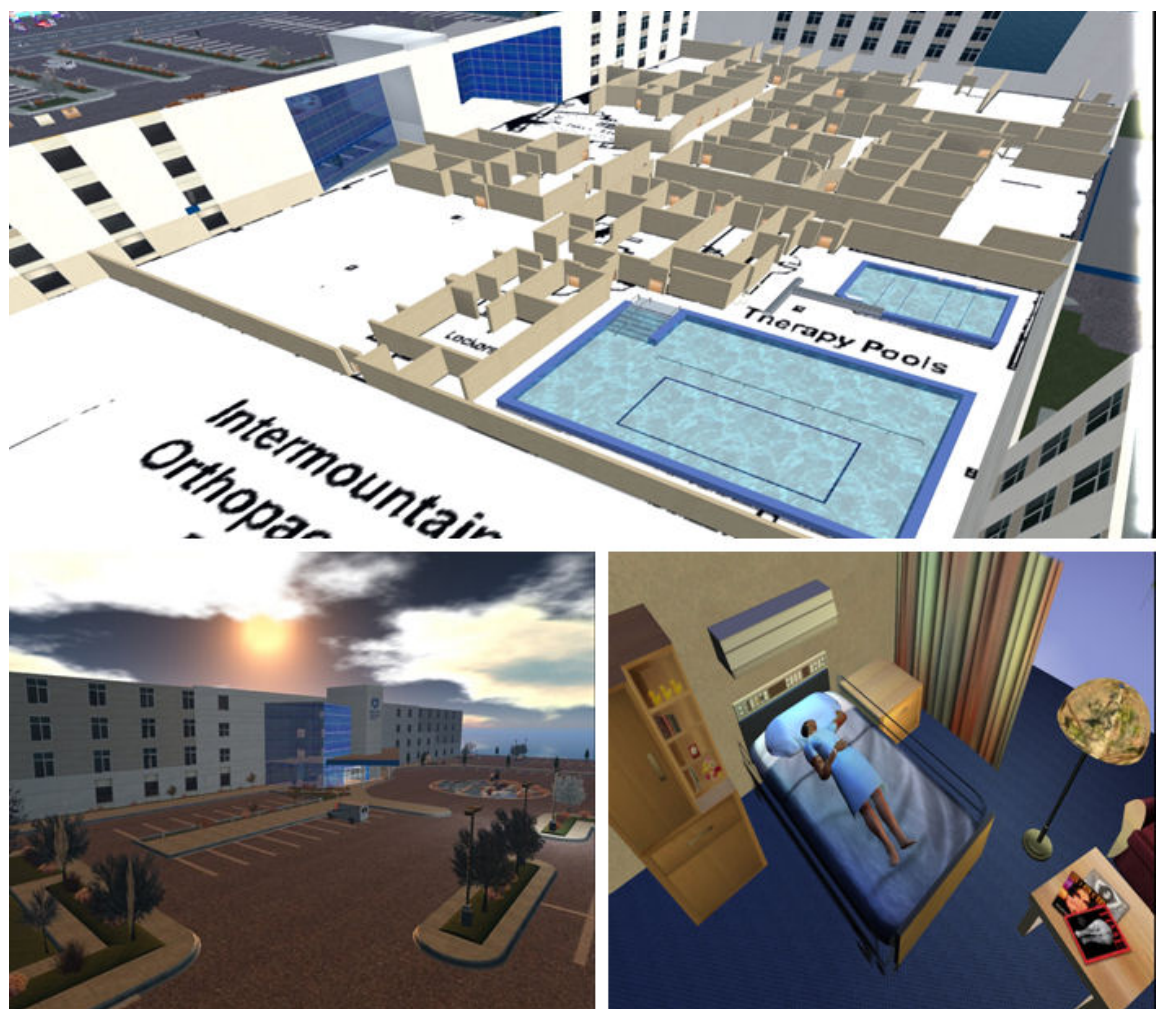
Figure 2. A realistic virtual replica of a real world